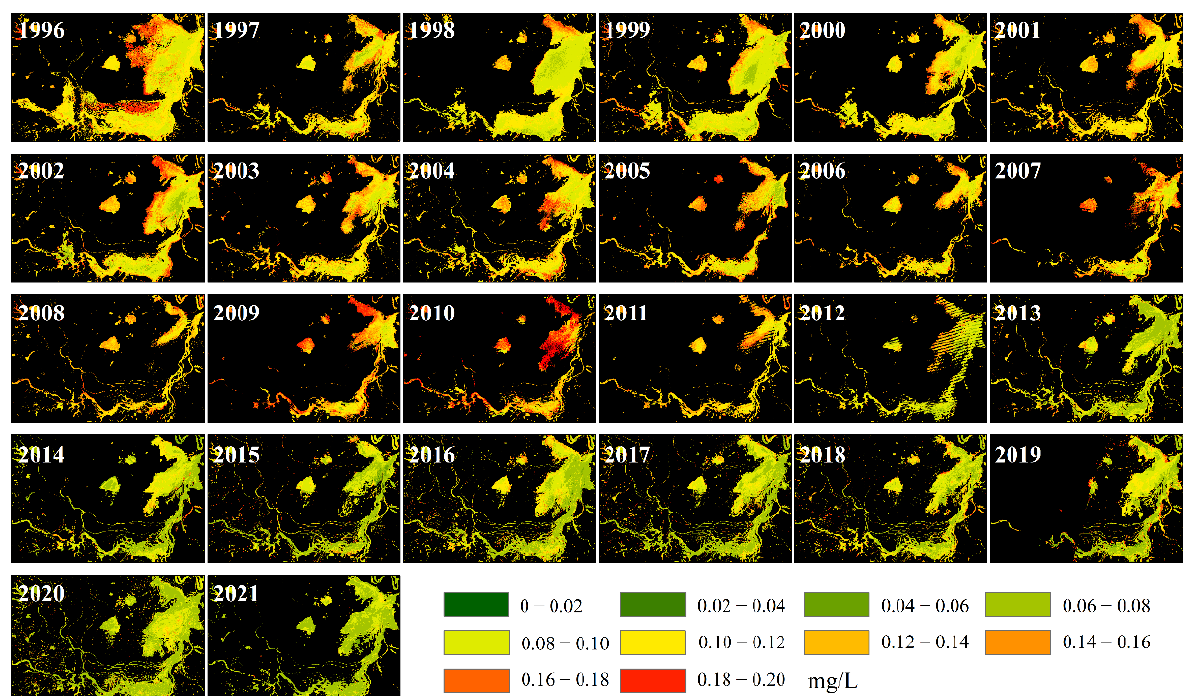
Figure 5. Spatial distribution of TP in Dongting Lake.